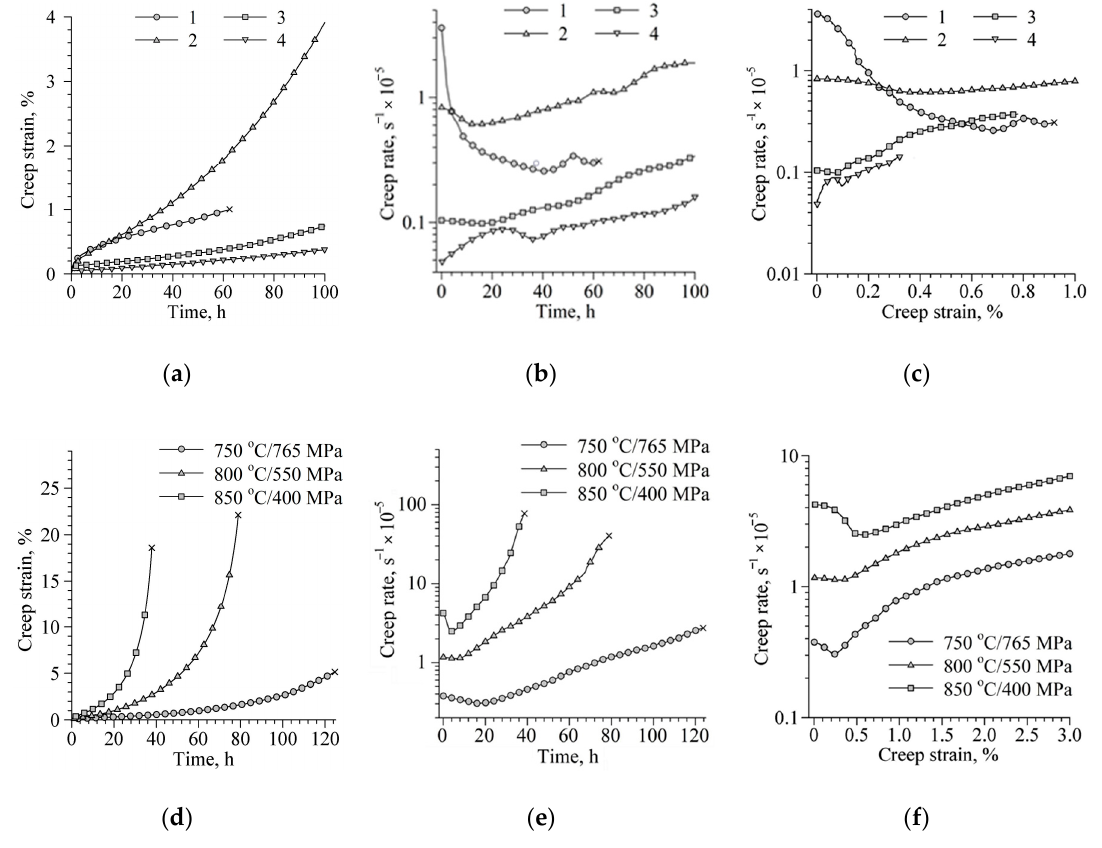
Figure 6. Creep behavior of the superalloy: ( a ) the creep curves obtained for conditions 1–4 at 750 ◦ C / 700 MPa, ( b ) the creep rate versus time plotted for conditions 1–4 at 750 ◦ C / 700 MPa, ( c ) the creep rate versus creep strain for conditions 1–4 at 750 ◦ C / 700 MPa, ( d ) the creep curves obtained for condition 3 at 750–850 ◦ C / 765–400 MPa, ( e ) the creep rate versus time plotted for condition 3 at 750–850 ◦ C / 765-400 MPa, and ( f ) the creep rate versus creep strain for condition 3 at 750–850 ◦ C / 765–400 MPa.